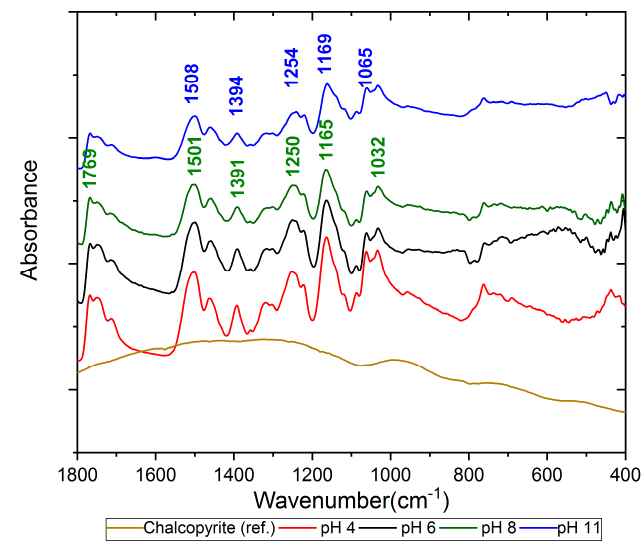
Figure 12. DRIFT spectra of thionocarbamate adsorption on chalcopyrite with increasing pH.